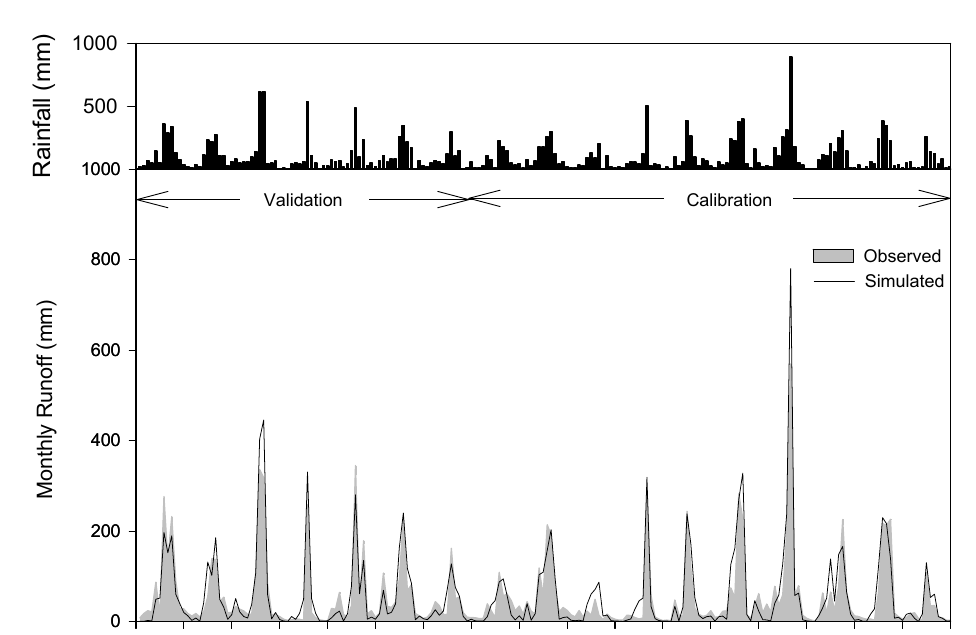
Figure 5. Monthly simulated and observed